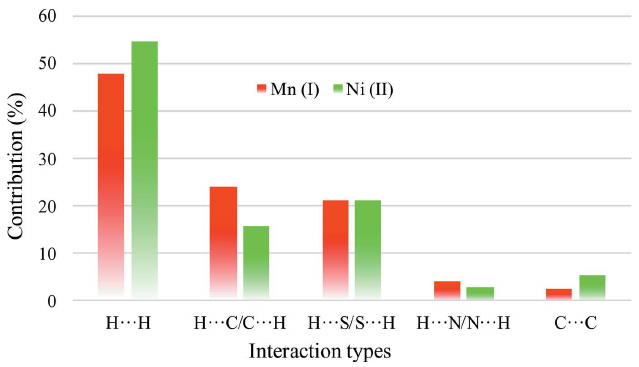
Figure 9 Quantitative results of different intermolecular contacts contributing to the Hirshfeld surfaces of ( I ) and ( II